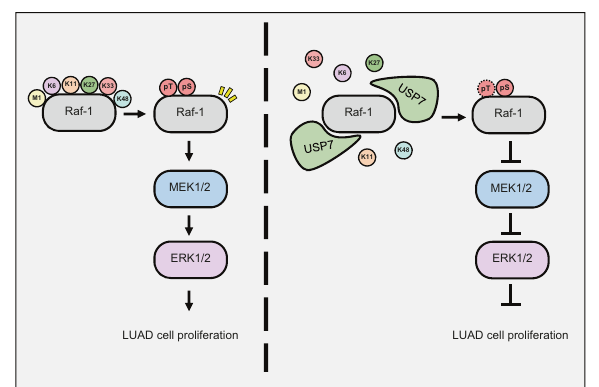
Fig. 6 A model for USP7 mediating the ERK1/2 signaling pathway through deubiquitination of Raf-1. USP7 deubiquitinates M1-, K6-, K11-, K27-, K33-, K48-linked polyubiquitin chains of Raf-1. And USP7 decreases the phosphorylation level of Raf-1 disrupting MEK1/2- ERK1/2 signal transduction through Raf activation. Inactivation of ERK1/2 signaling pathway inhibits the proliferation of lung adenosarcoma cells though delaying the G2/M